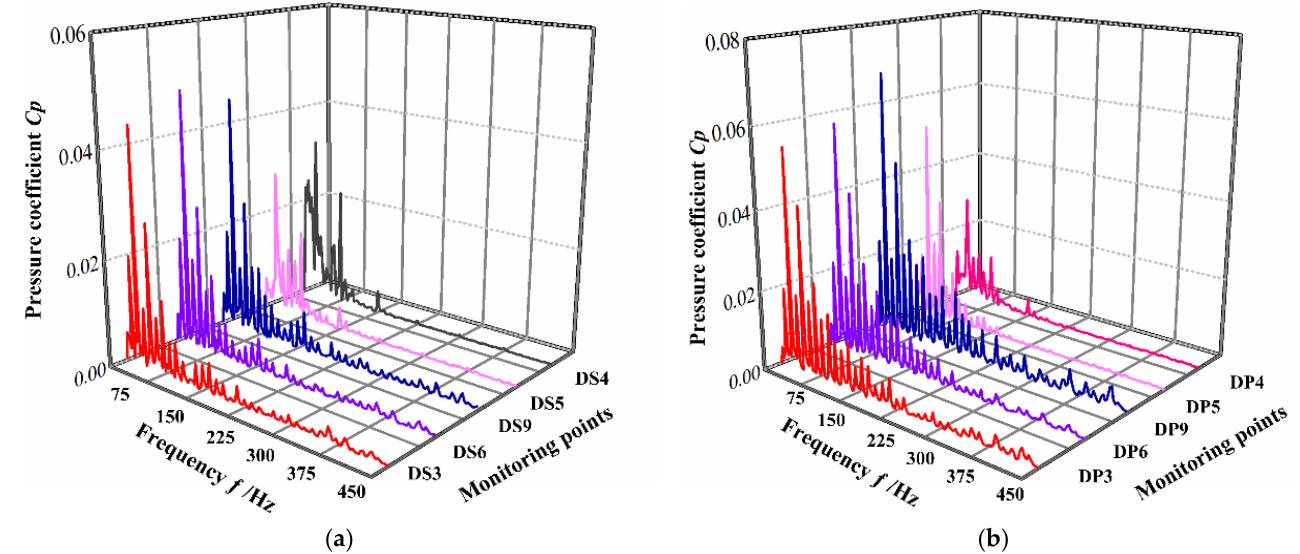
Figure 15. Frequency domain diagram of second-stage double-suction impeller at 1.0 Q. ( a ) Monitoring points of blade suction side, ( b )Monitoring points of blade pressure side.